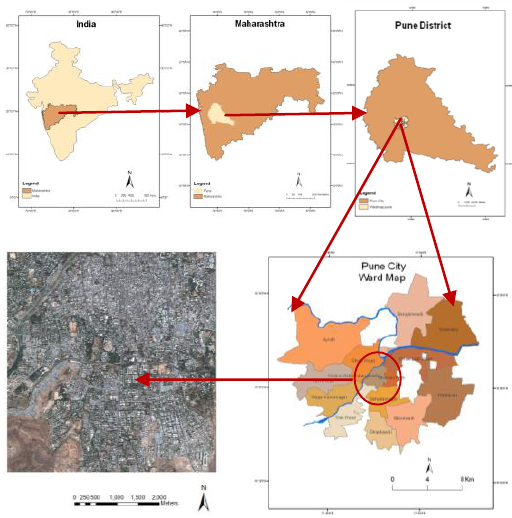
Figure 1.Location of Pune city and Quick Bird scene